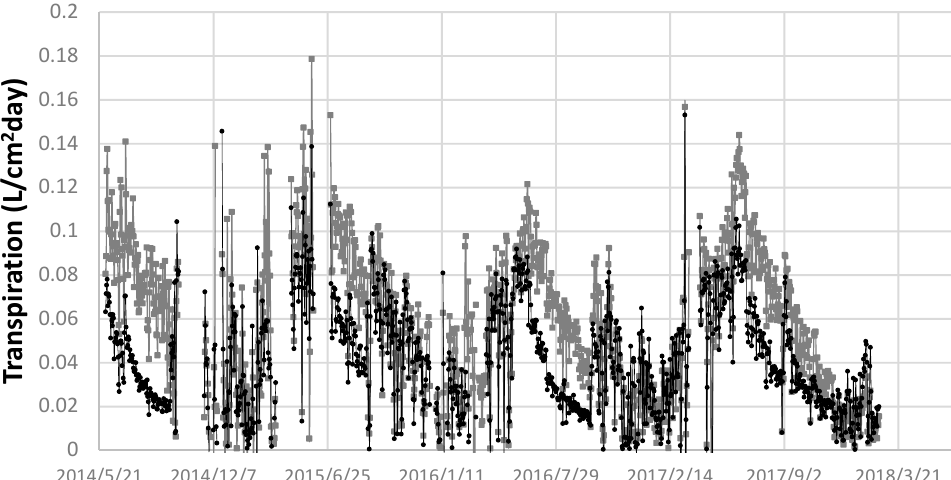
Figure 3. Transpiration (litres per cm 2 of sapwood area per day) of Q. ilex (grey) and P. halepensis (black) during the study period.